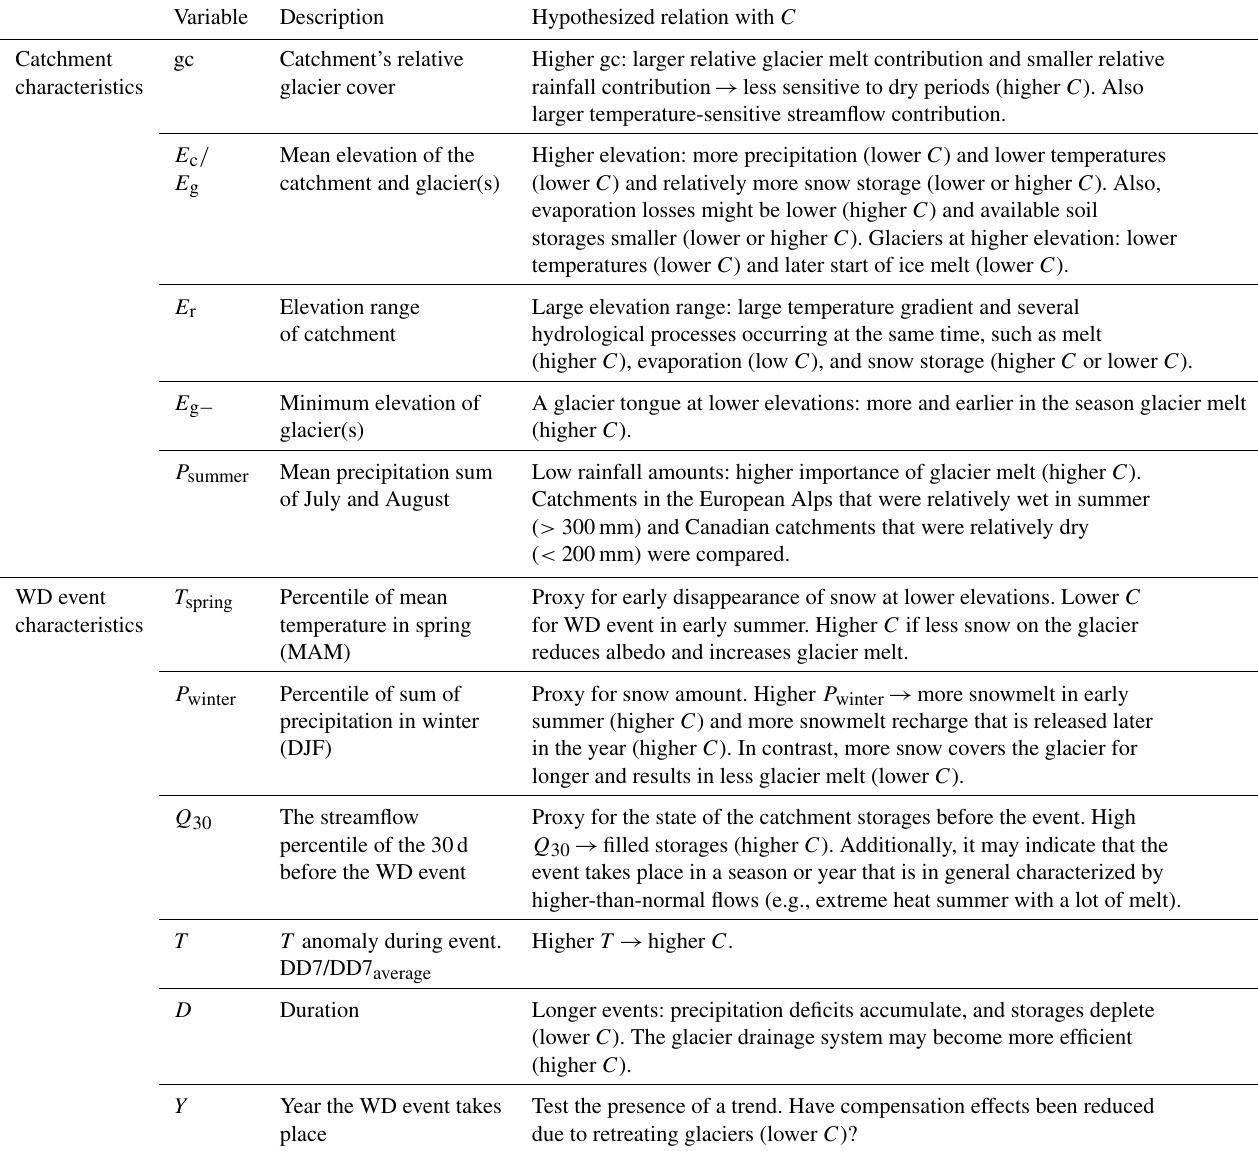
Table 2. Catchment and event characteristics that were used to explain the variability in the level of compensation ( C ). Variable Description Hypothesized relation with C Catchment gc Catchment’s relative Higher gc: larger relative glacier melt contribution and smaller relative characteristics glacier cover rainfall contribution → less sensitive to dry periods (higher C ). Also larger temperature-sensitive streamflow contribution. Higher elevation: more precipitation (lower C ) and lower temperatures catchment and glacier(s) (lower C ) and relatively more snow storage (lower or higher C ). Also, evaporation losses might be lower (higher C ) and available soil storages smaller (lower or higher C ). Glaciers at higher elevation: lower temperatures (lower C ) and later start of ice melt (lower C